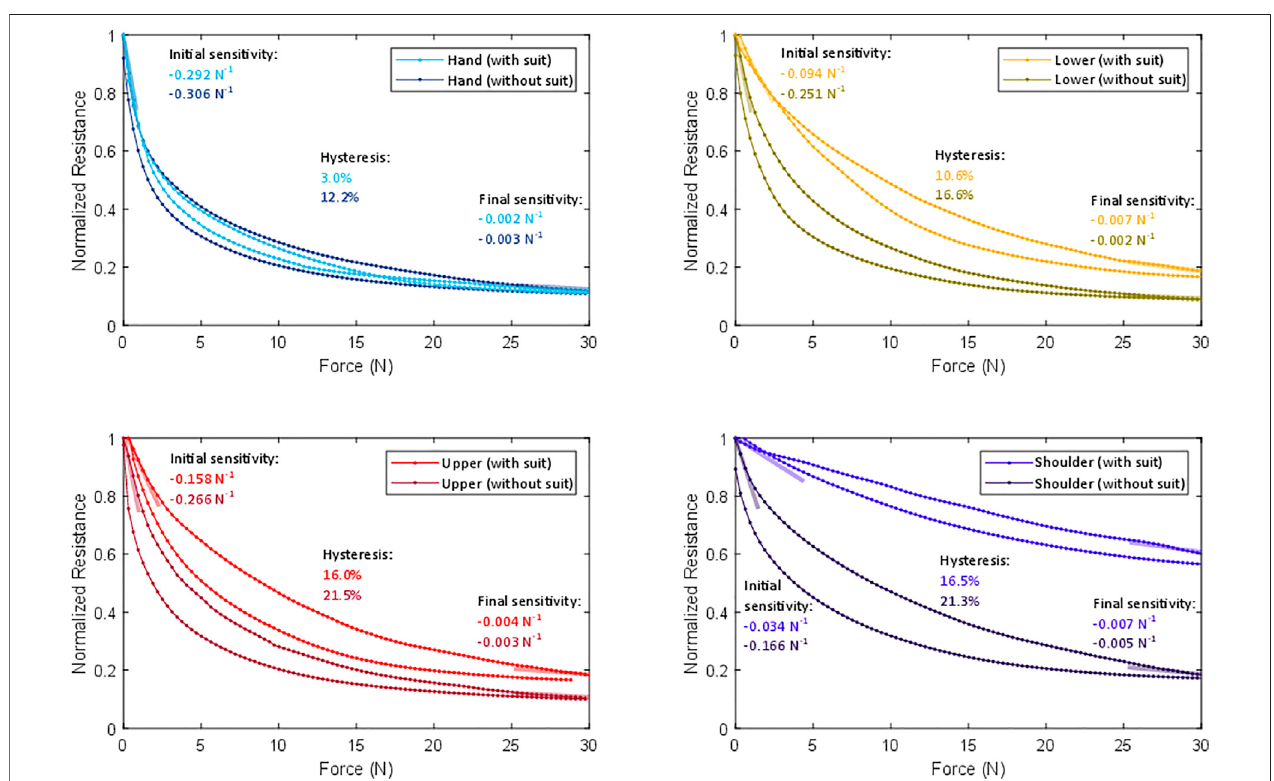
FIGURE 9 | Normalized comparisons of individual sensor ’ s resistances across the tested force range with and without the koala suit, averaged across all trials of each physical experiment. The initial and fi nal sensitivities are represented using semi-transparent lines oriented at the appropriate slopes. Each plot also lists the corresponding numerical values for sensitivity and